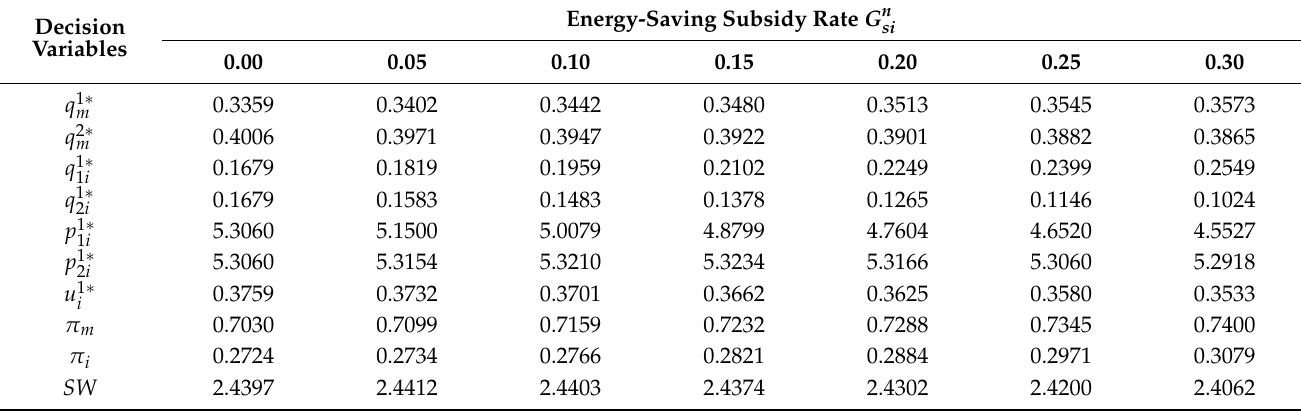
Table A3. The equilibrium result of government subsidies to all retailers in market 1 when demand scales of HEEP and LEEP is different.